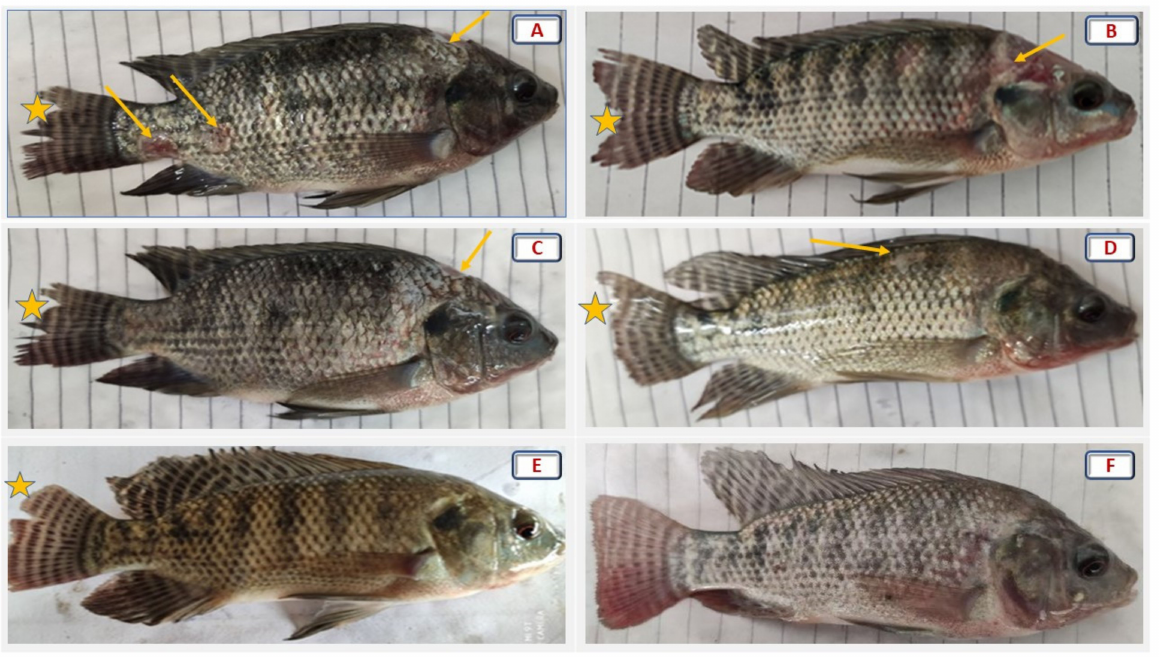
Figure 6. Effect of increasing dietary levels of Alchemilla vulgaris on columnaris clinical symptoms of Oreochromis niloticus challenged with pathogenic Flavobacterium columnare for 12 days. Stars identify fin rots, and arrows identify pale ulcers with hemorrhagic boundaries, especially on the upper head (saddleback lesion) and caudal peduncle. ( A ) 0 g AVP/kg diet, ( B ) 2 g AVP/kg diet, ( C ) 4 g AVP/kg diet, ( D ) 6 g AVP/kg diet, ( E ) 8 g AVP/kg diet, ( F ) 10 g AVP/kg